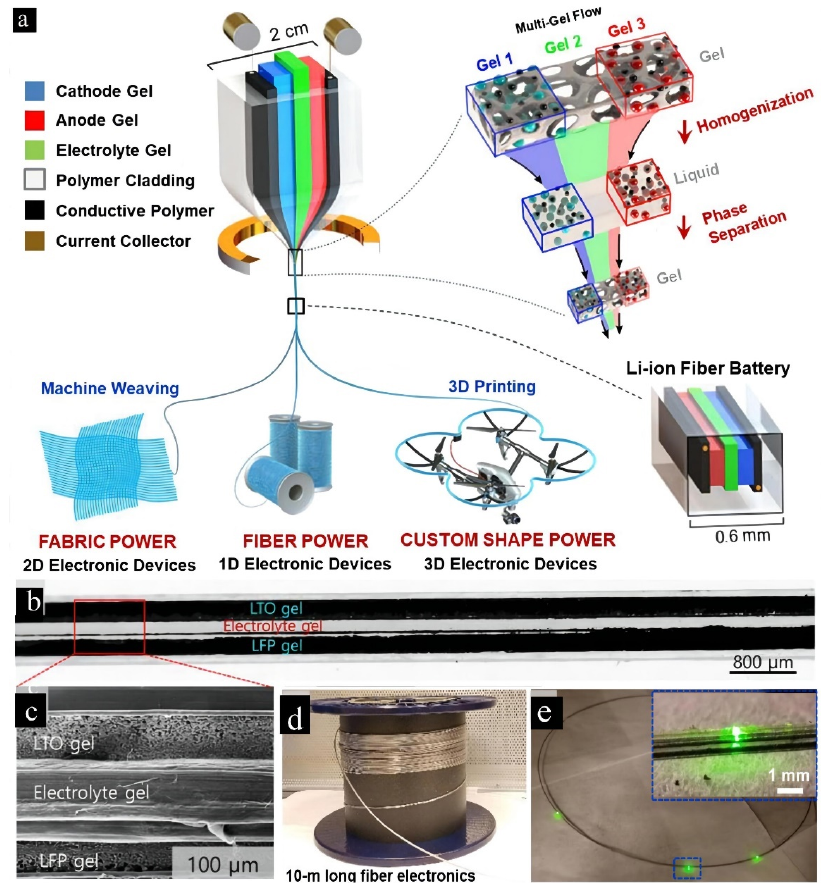
Figure 5. ( a ) Configuration schematic of fiber-shaped batteries. ( b ) Image of the electrode cross- section. ( c ) SEM image of the fiber-shaped battery. ( d ) A 10 m LED/battery fiber. ( e ) LEDs lit by fiber battery. Reprinted with permission from [51]. Copyright Elsevier Publisher, 2022.